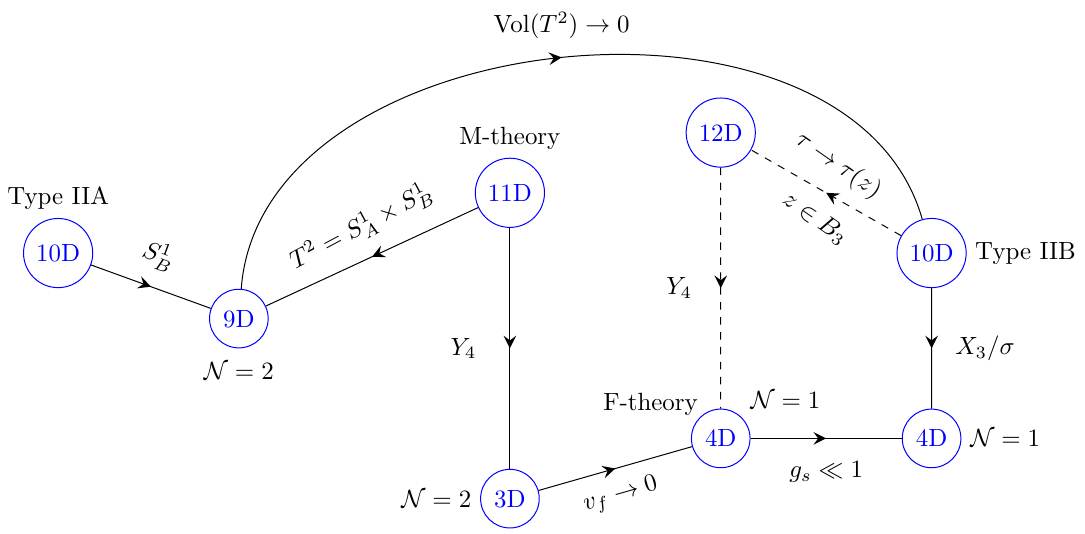
Figure 1 . Schematic picture of dualities and limits of the various theories in different dimensions employed throughout this